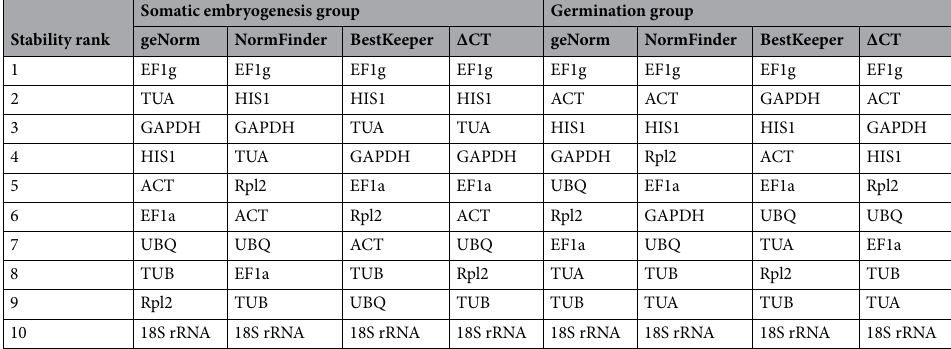
Table 3. Expression stability of reference genes analyzed by geNorm, NormFinder, BestKeeper and delta Ct.